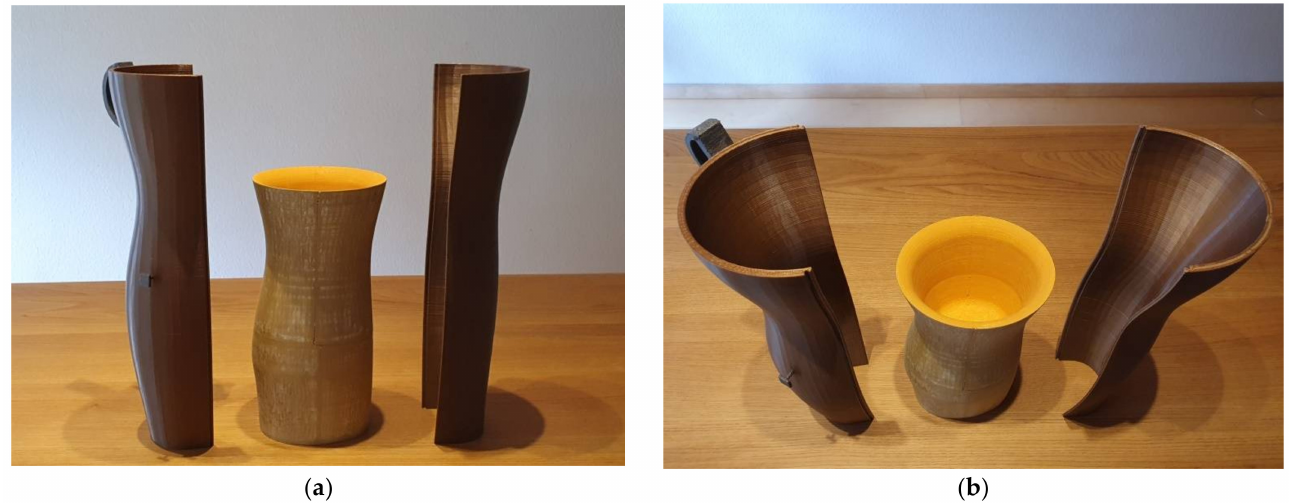
Figure 3. 3D print of the reconstructed Capua leg, disassembled into its three parts: ( a ) View from the side; ( b ) View from the side above.